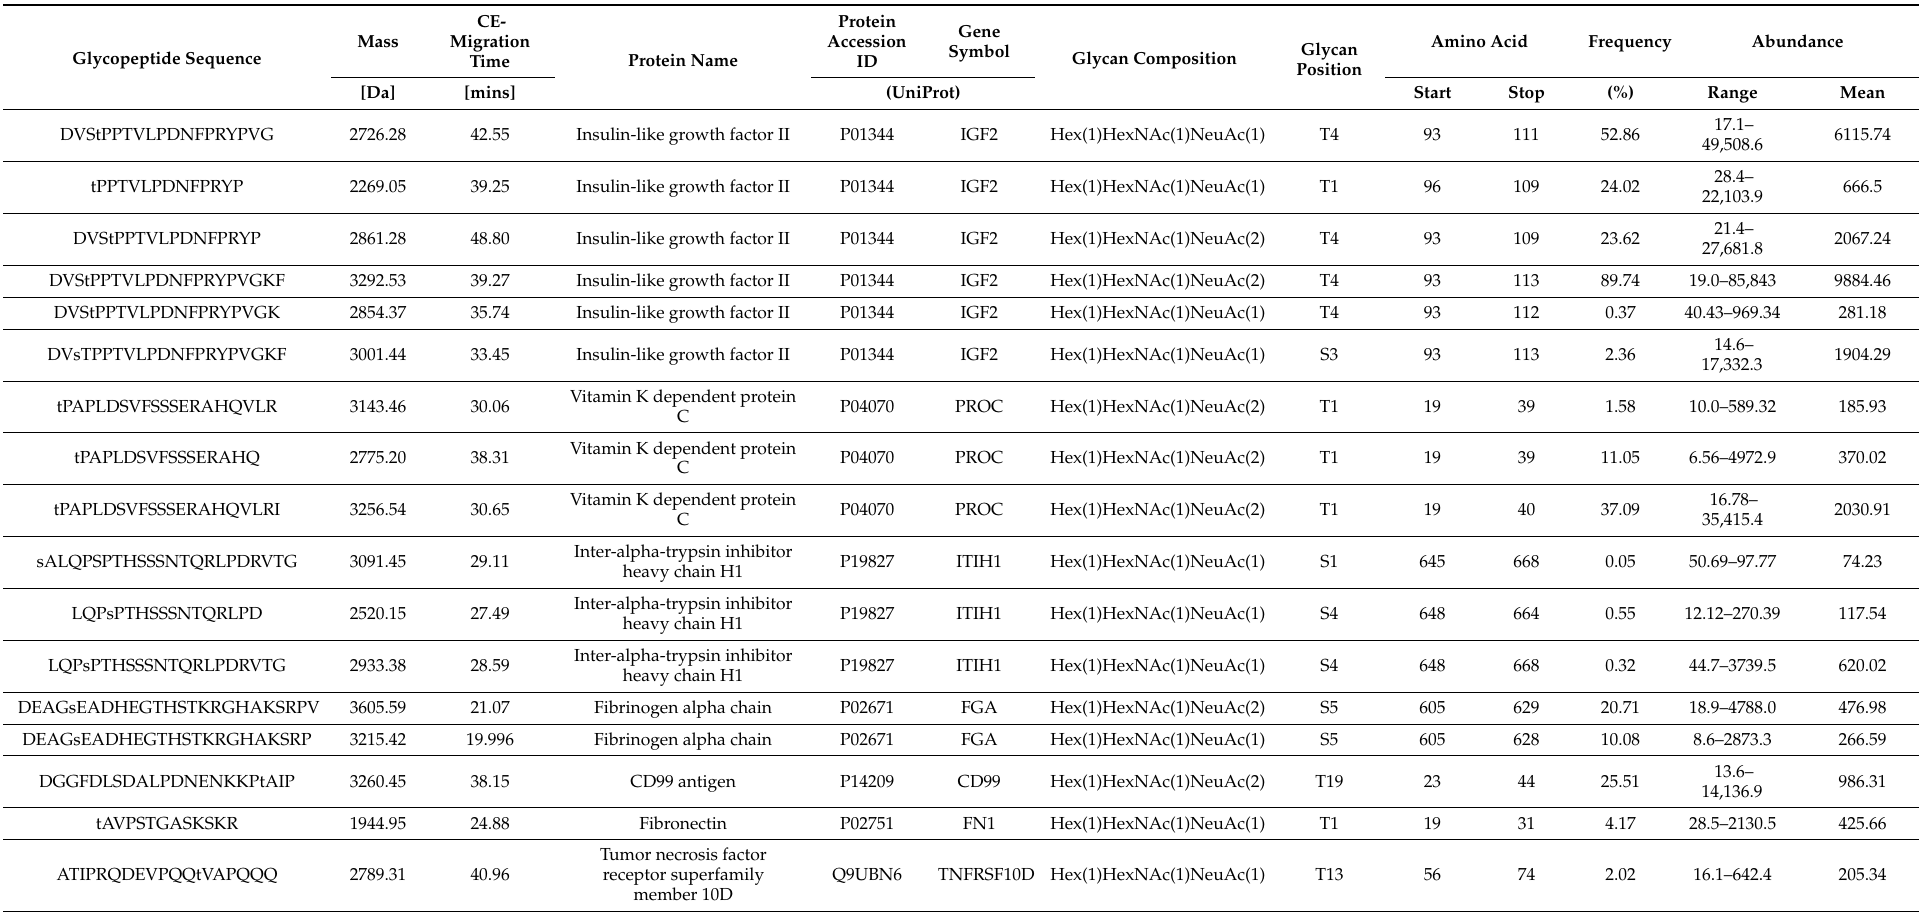
Table 1. List of 17 O-linked glycopeptides identified by CE-MS/MS-based urinary glycopeptidomics analysis. The peptide frequency of detection (%) and abundance distribution in the Human urinary proteome database ( n = 3810) are